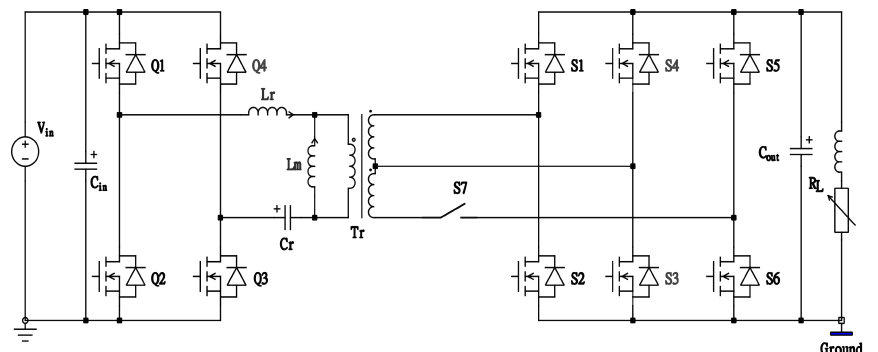
Figure 3. Proposed reconfigurable LLC converter